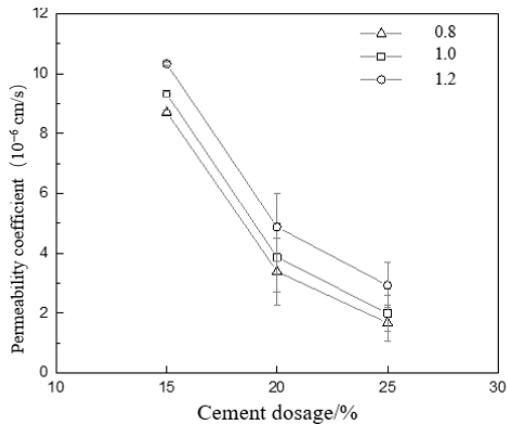
Figure 8. Permeability coefficient of cement–soil with different contents of cement.